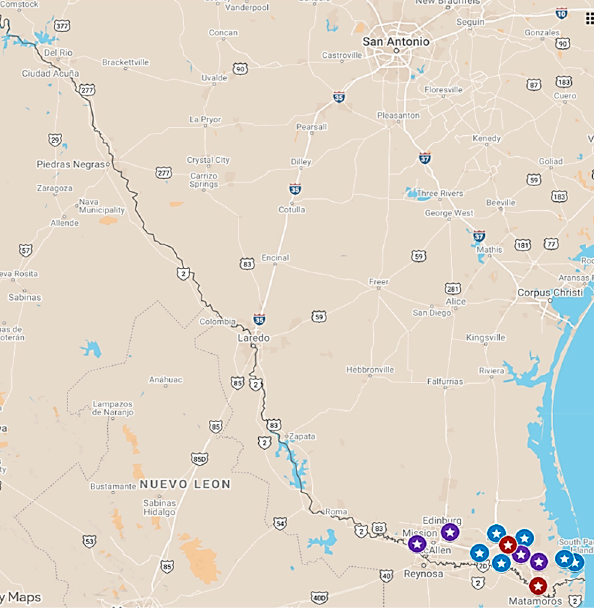
Figure 1. Map of Participating TSSC Implementing Locations. Google map showing the location of the 12 municipalities in the TSSC study along the U.S.-Mexico border. Red labels are “Cities” with population sizes ranging from 75,000–200,000. Purple labels are “Towns” with a population sizes from 10,000–70,000. Blue labels are “Rural” areas, each with a population of <5000. The straight-line distance between the farthest west (purple star) and east (blue star) locations is about 80 miles (130 km).